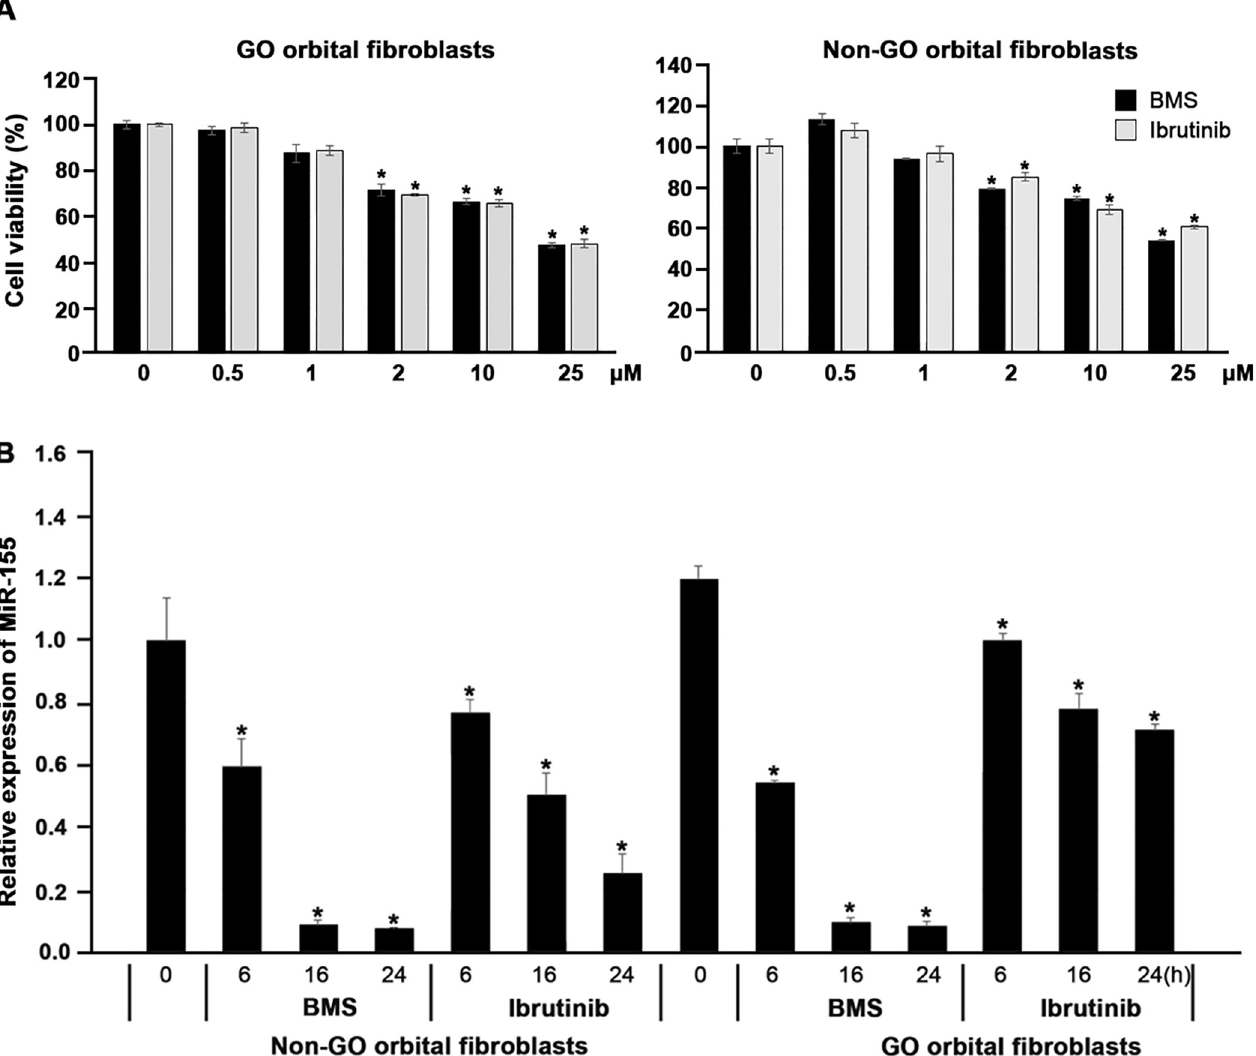
Fig 7. Effect of interleukin-2-inducible T-cell kinase (ITK) inhibitors and Bruton’s tyrosine kinase (BTK)/ITK dual inhibitors on the viability and microRNA-155 expression of orbital fibroblasts in Graves’ orbitopathy (GO) (n = 3) and non-GO (n = 3). (A) Based on the MTT results, exposure of cells to � 1 μ M of ITK inhibitors and BTK/ITK dual inhibitors for 24 hours did not reduce cell viability to levels below 80% in GO OFs or 90% in non-GO OFs. (B) The expression of miR-155 was significantly downregulated by treatment with ITK inhibitors and BTK/ITK dual inhibitors, in a time-dependent manner in both GO and non-GO OFs. Differences between treated and untreated cells are indicated (in contrast to cells no treated with ITK, BTK/ITK inhibitors, � P <